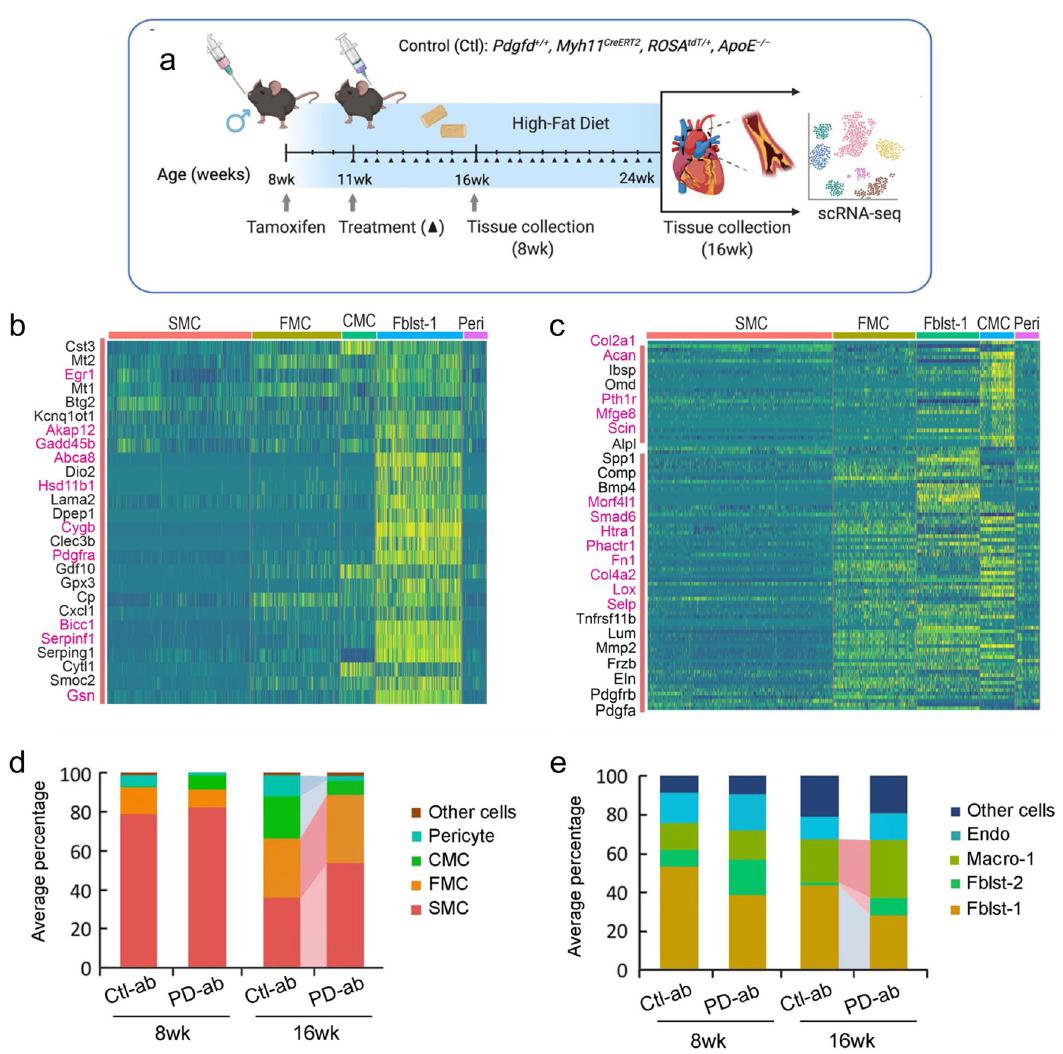
Fig.6|SinglecellRNA-seqstudiesofantibody-mediatedPdgfdinhibitioninthe mouse atherosclerosis model. a Schematic of experimental design showing that SMC-speci fi clineagetracing wildtypemiceweretreated withtamoxifenat8weeks of age and tissues harvested after 8 and 16 weeks of high fat diet. Blocking Pdgfd antibody or isotype control antibody administration,10mg/kg subcutaneously twice weekly, was initiated at 11 weeks and continued until animals were sacri fi ced after either 8 weeks exposure to the diet (5 weeks antibody) or 16 weeks diet (13 weeks antibody), and scRNAseq conducted at these timepoints. Created with BioRender.com. b Heatmap showing gene expression changes after 5 weeks of antibody treatment. The Fblst-1 cluster shows early downregulation of Pdgfd-